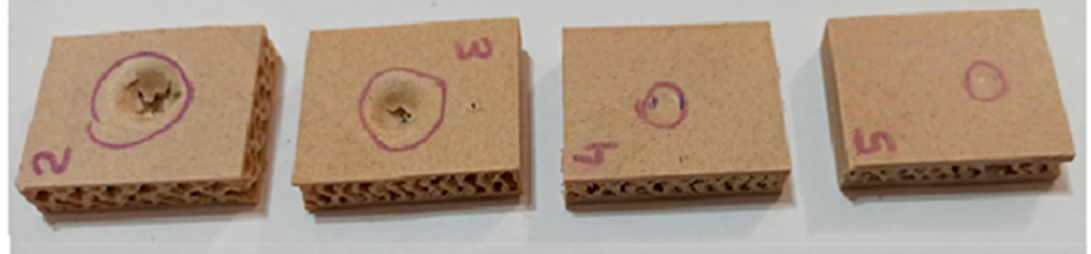
Figure 5. E ff ect of face thickness on the Brinell hardness of the wood / PLA specimens with a gyroid